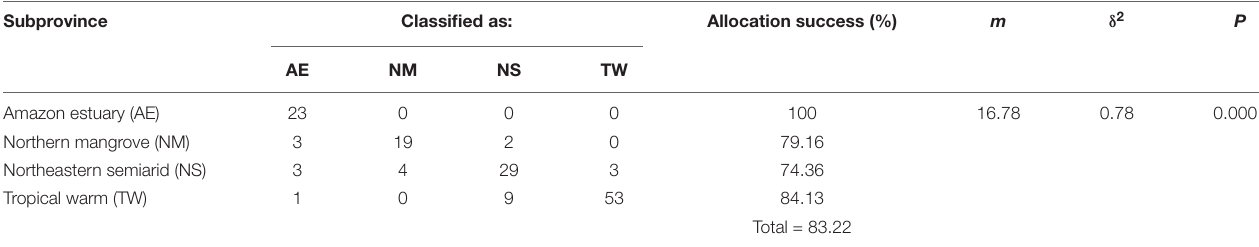
TABLE 2 | Results of the Canonical Analysis of Principal coordinates (CAP), which examines the effect of the “subprovince” factor on the tidepool fish